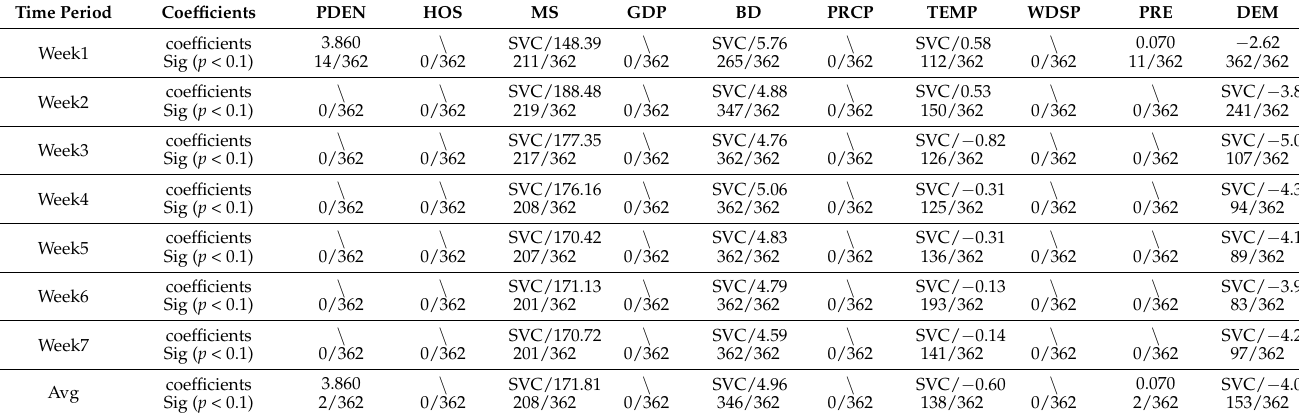
Table 13. ESF-SVC model coefficients Mainland